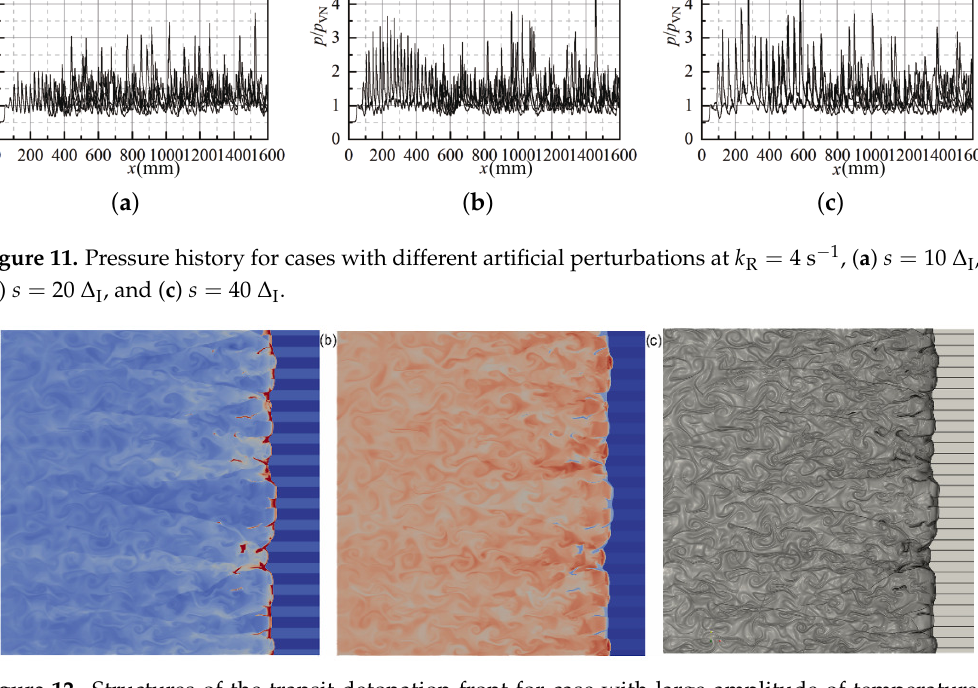
Figure 12. Structures of the transit detonation front for case with large amplitude of temperature perturbations ( A = 55 K, k R = 3 s − 1 and s = 20 ∆ I ), ( a ) density, ( b ) temperature, and ( c ) Schlieren photography.